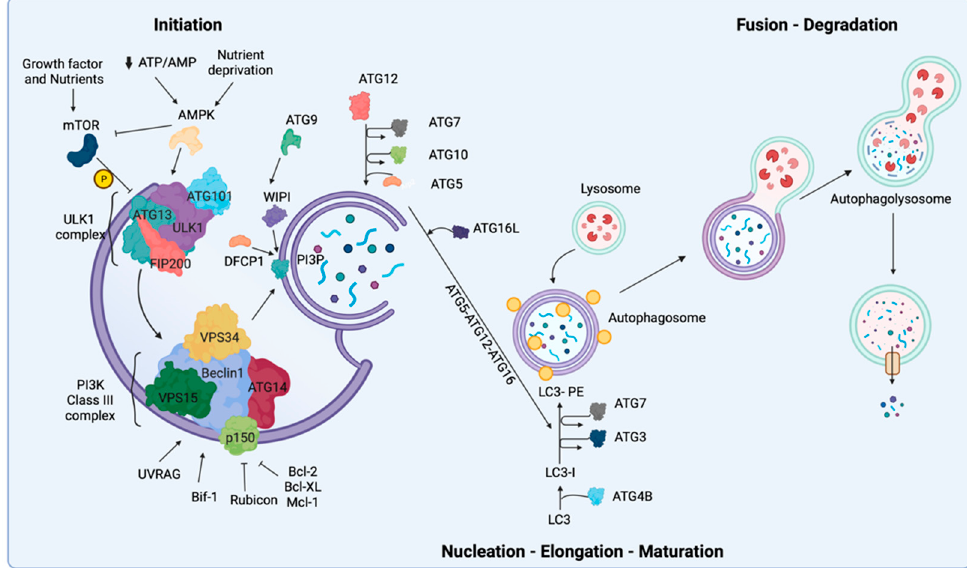
Figure 1. The regulation of mammalian autophagy. Under growth factors and nutrients, mTOR negatively regulates the initiation of autophagy by inhibiting the formation of the ULK1 complex (comprised of ATG13, ULK1, FIP200, and ATG101) through phosphorylation of the ATG13 subunit. Under nutrient deprivation, AMPK detects altered levels of the ATP/AMP ratio and downregulates mTOR activity, resulting in ULK1 complex activation. During phagophore nucleation, the ULK1 complex recruits and activates the PI3KC3 complex (which includes Beclin-1, ATG14, VPS 34, VPS15 and p150). Both negative regulators, Bcl-2, Bcl-XL and Mcl-1, and positive regulators, UVRAG, Bif-1 and Rubicon, can modulate PI3KC3 complex activity. The activation of PI3KC3 increases PI3P, which enhances PI3P interaction with WIPI and DFCP1. Elongation and maturation involve two ubiquitin-like conjugation systems. In the first system, ATG12–ATG5 binds and interacts with the ATG16L1 protein to form a multimeric complex: ATG5-ATG12-ATG16. The second system is orchestrated by LC3. LC3 undergoes a proteolytic cleavage by ATG4B proteases, which forms LC3-I. Consequently, via ATG7, ATG3 and ATG12-ATG5-ATG16, the PE are conjugated to LC3-I, which induces the formation of LC3-II and facilitates the closure of the phagophore. During fusion, the lysosomal membranes form autolysosomes by fusing with the autophagosomes. The contents of the autophagosome are then degraded by hydrolytic enzymes and the cellular components transform into building blocks that are transported from the lysosomal lumen into the cytosol.